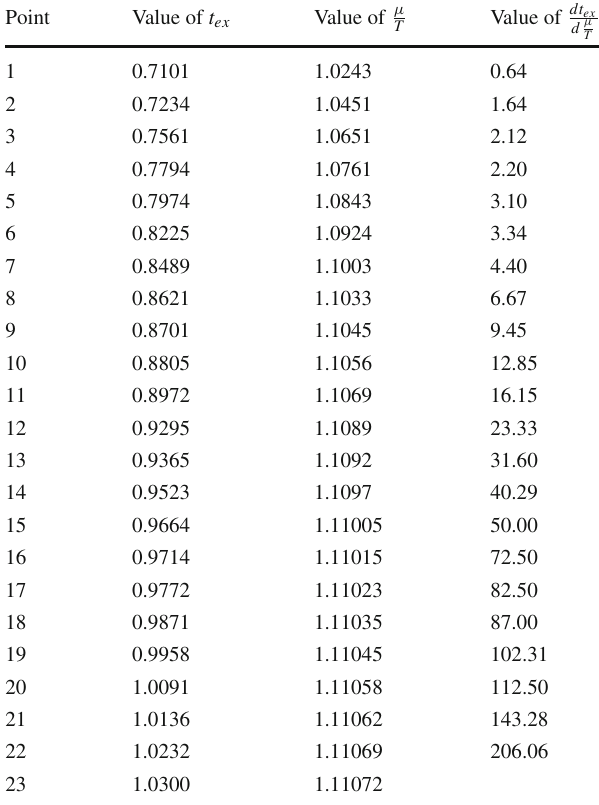
and dt ex used for the fit procedure for T d μ T